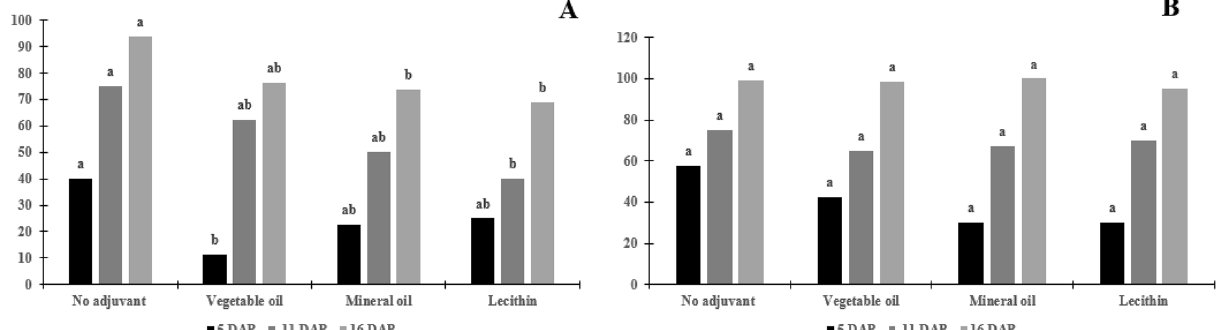
Figure 3. Percentage of control of Crotalaria incana L. plants after herbicide solution spraying. ( A ) Aminopyralid + fluroxypyr at 155.3 L of active ingredient ha −1 . ( B ) Aminopyralid + fluroxypyr at 360.6 L of active ingredient ha −1 . Equal letters within the evaluation days, the adjuvants do not differ from each other by the Tukey test (p >